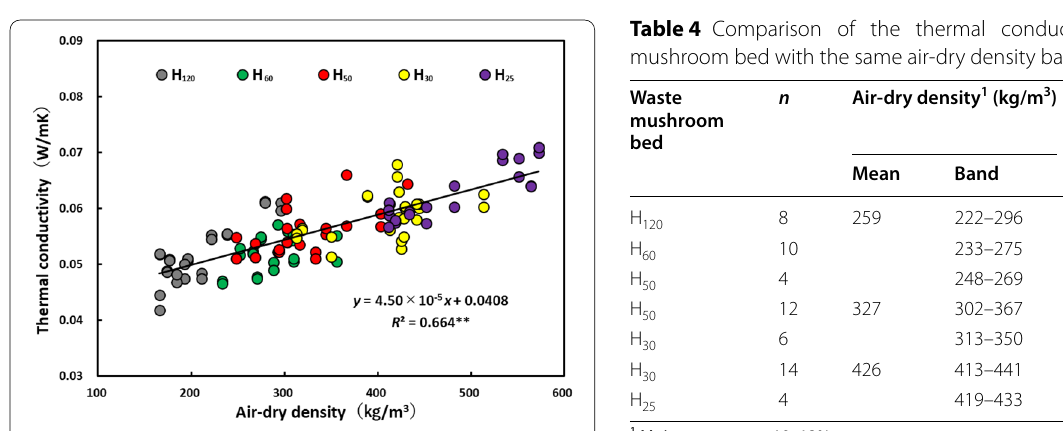
Fig. 7 Relationship between the air-dry density and thermal conductivity of the waste mushroom bed